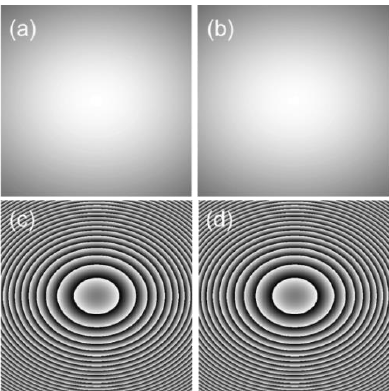
Figure 3. Simulation results: ( a ) intensity of the original object wave; ( b ) intensity of reconstructed object wave; ( c ) original phase distribution; ( d ) reconstructed phase distribution.